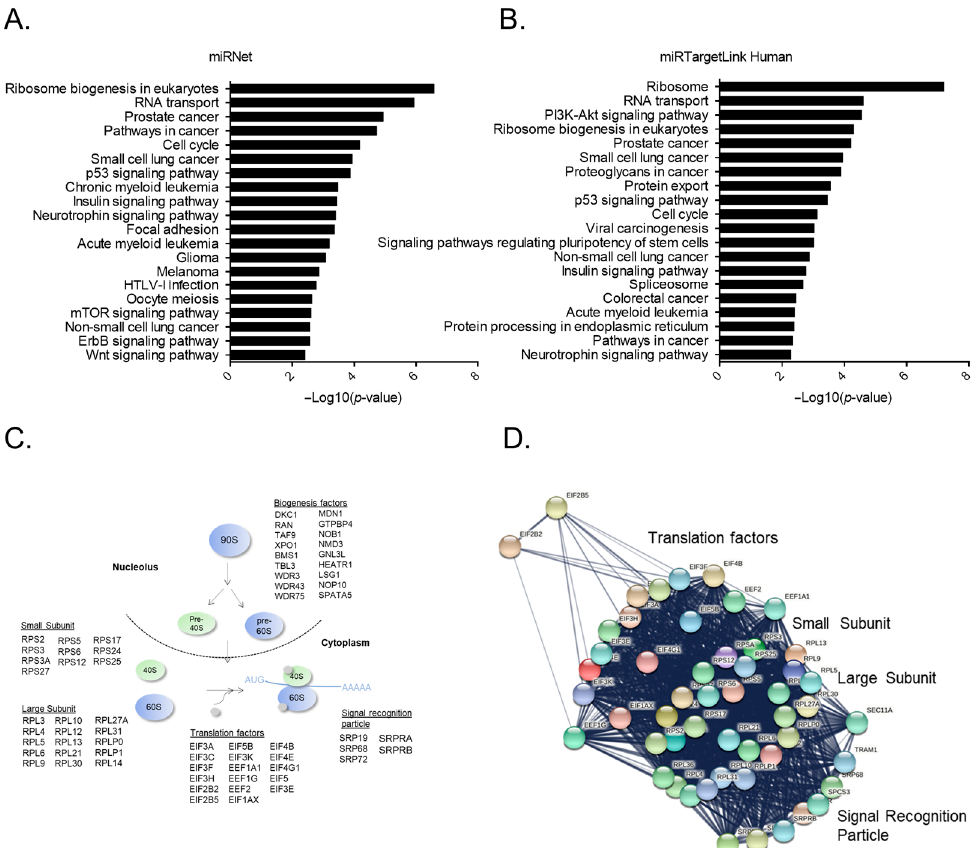
Figure 4. Bioinformatic analysis of the miR-16-5p target genes. ( A , B ) Functional enrichment analysis of the most significant pathways among the miR-16-5p target genes retrieved through ( A ) miRNet and ( B ) miRTargetLink. Each bar plot represents a KEGG pathway ranked in a descending order based on their calculated p -values. The analysis was performed using the miRNET functional enrichment tool. ( C ) Graphical representation of major steps of ribosome biogenesis, translation initiation and regulation, depicting the genes affected by miR-16-5p. ( D ) Protein–protein interaction network between the genes shown in B. The network analysis was performed with the String database tool. Network edges represent protein–protein interactions, sourced from text mining, experiments, databases, coexpression, neighborhood, gene fusion and co-occurrence.